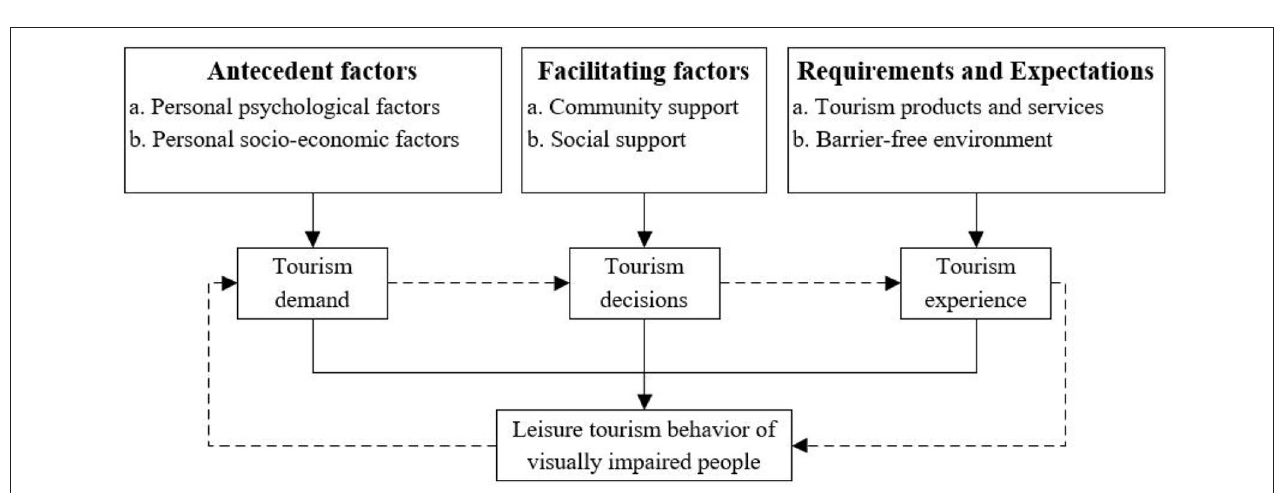
FIGURE 2 | Path model showing the factors influencing visually impaired individuals during the various tourism